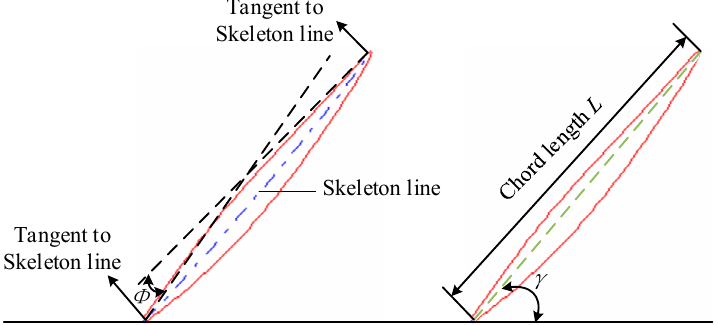
Figure 2. Design diagram of bidirectional impeller based on NACA 65 airfoil.